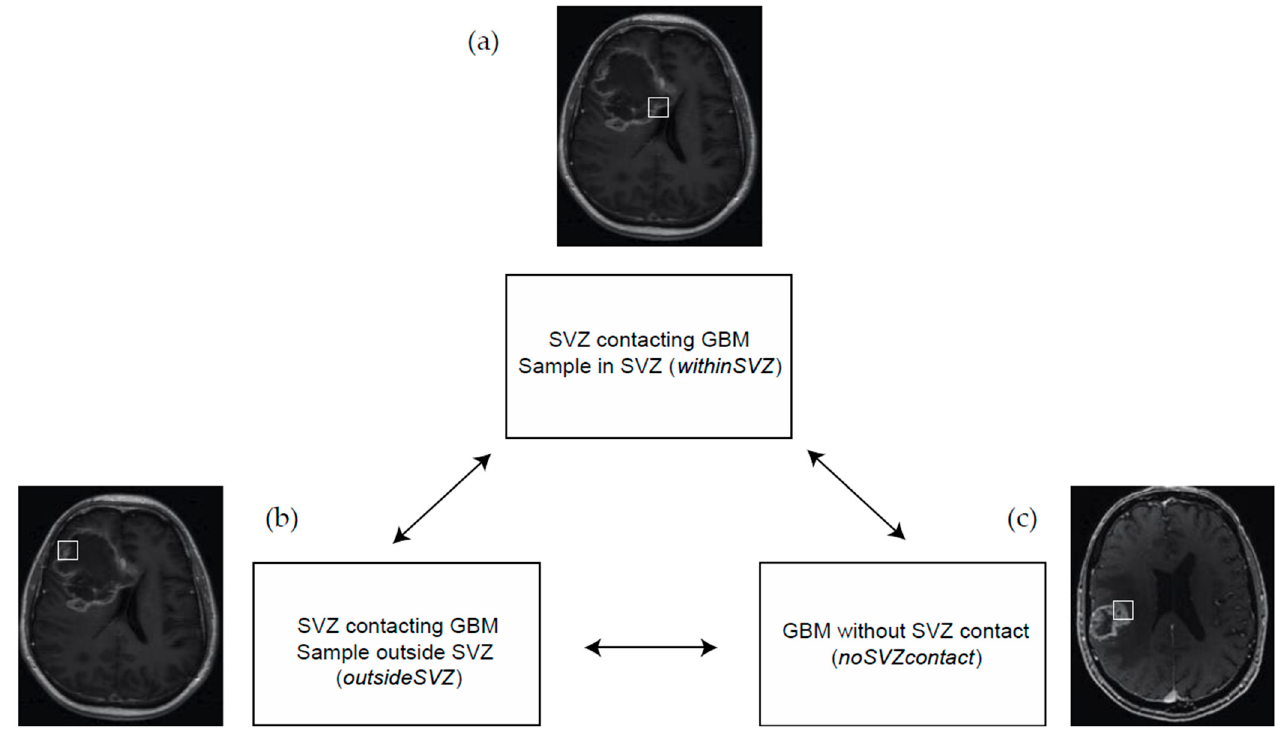
Figure 2. Analysis overview. In our study, we compare gene (set) expression between ( a ) glioblastoma samples within the SVZ ( withinSVZ samples), ( b ) samples outside of the SVZ from SVZ-contacting glioblastomas ( outsideSVZ samples), and ( c ) samples from tumors without SVZ contact ( noSVZcontact samples).